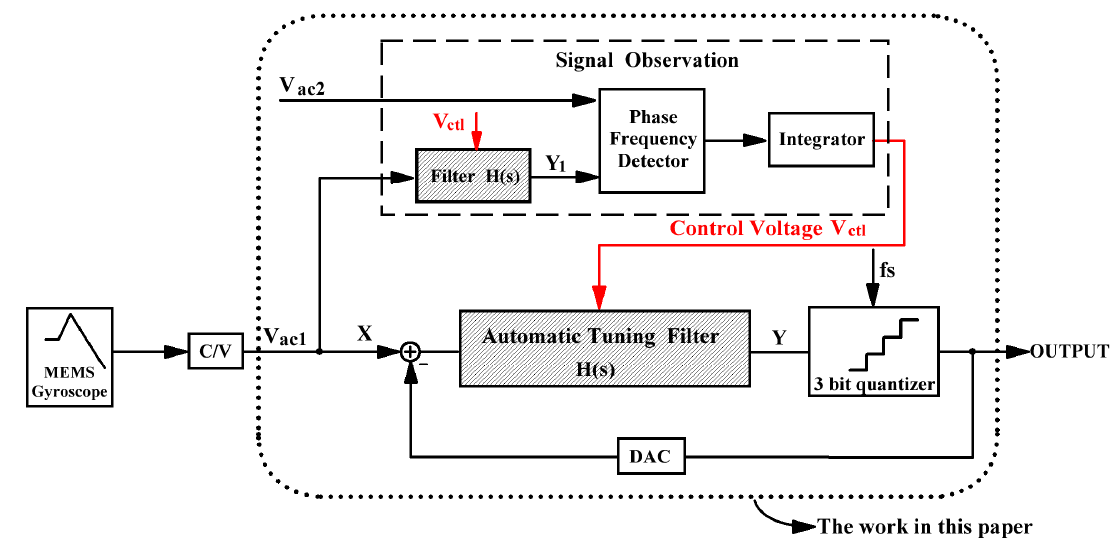
Figure 2. Schematic of the frequency tuning based on Σ∆ modulator for micro-electromechchanical systems (MEMS) gyroscope readout systems. The work of this paper in the rounded rectangle realizes the complete on-chip integration.